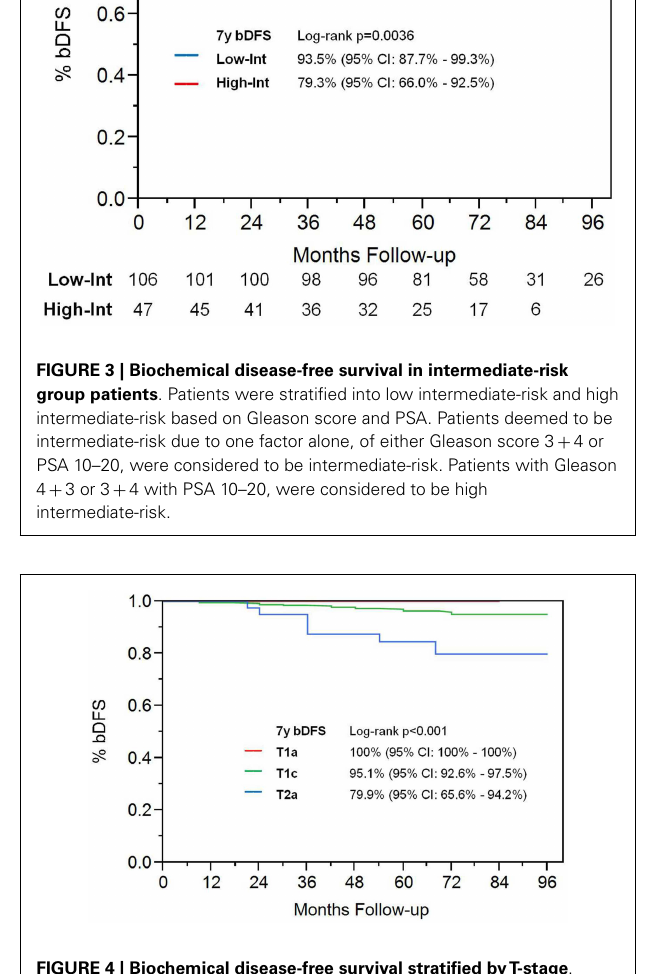
FIGURE 6 | Biochemical disease-free survival stratified by SBRT dose in low-risk and low intermediate-risk group patients